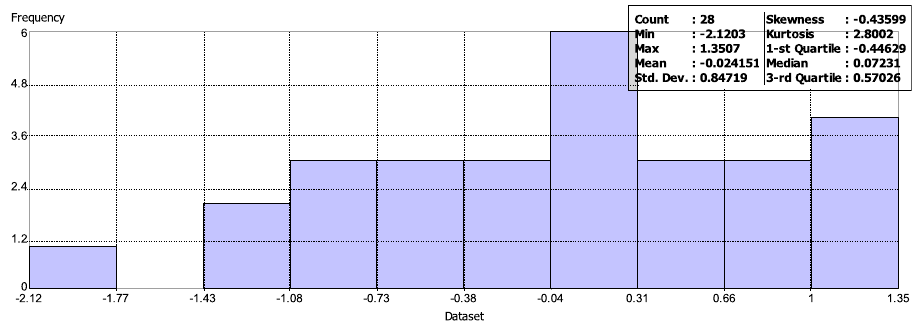
Fig. 3 Transformed